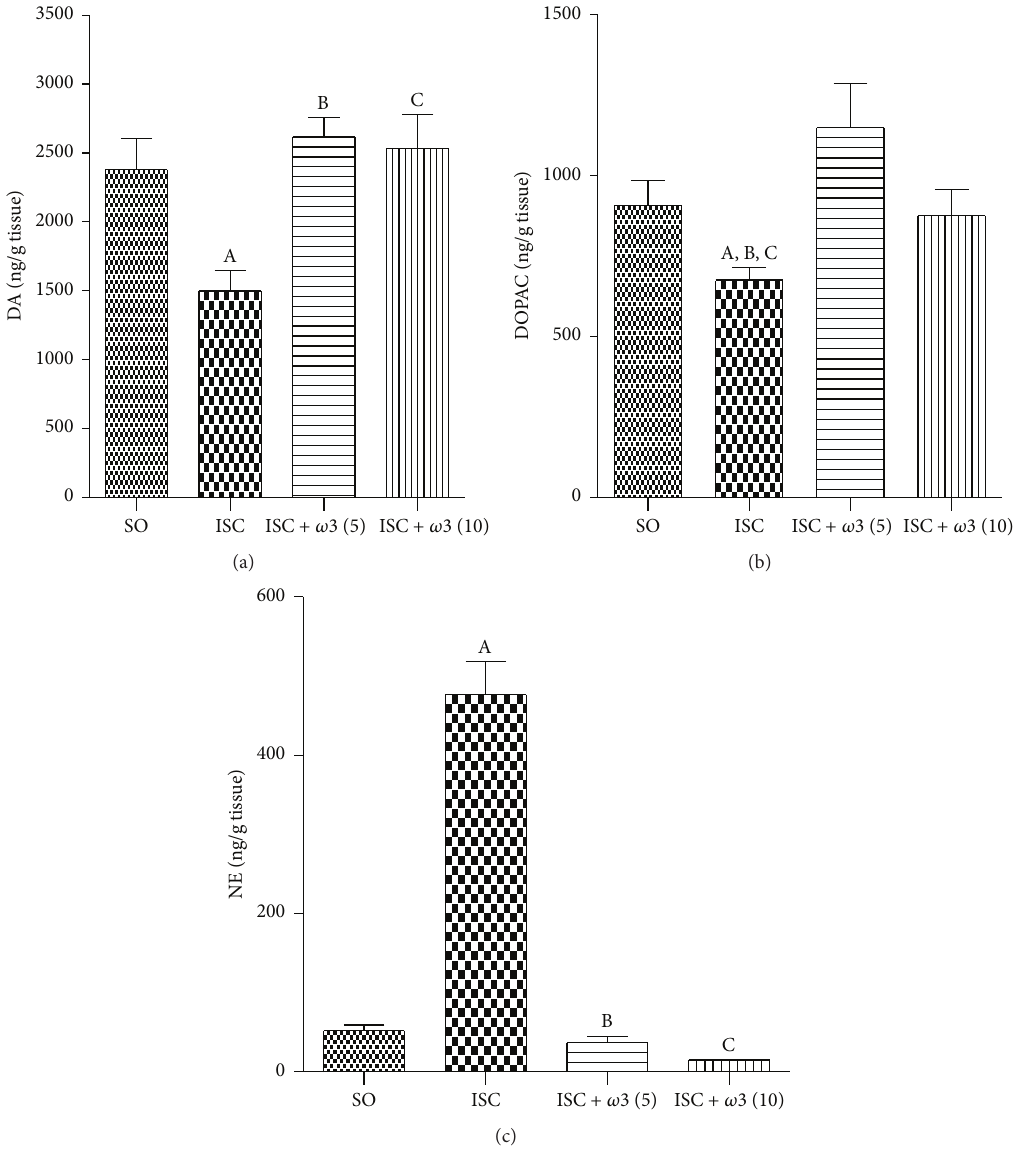
Figure 3: Evaluation of 𝜔 3 treatments at the doses of 5 and 10mg/kg on the striatal contents of DA (a), DOPAC (b), and NE (c), in rats subjected to brain ischemia and reperfusion for 7 days. The numbers of animals per group were the following: for DA, SO = 14, ISC = 9, ISC + 𝜔 3 (5) = 19, and ISC + 𝜔 3 (10) = 15; for DOPAC, SO = 14, ISC = 11, ISC + 𝜔 3 (5) = 15, and ISC + 𝜔 3 (10) = 14; for NE, SO = 8, ISC = 10, ISC + 𝜔 3 (5) = 8, and ISC + 𝜔 3 (10) = 6. The columns represent means ± SEM and the groups are sham-operated (SO); ischemic (ISC) untreated; and ischemic after 𝜔 3 treatments for 7 days. DA: (A) versus SO, q = 3.830 ∗∗ ; (B) versus 𝜔 3 (5), q = 5.145 ∗∗ ; (C) versus 𝜔 3 (10), q = 4.570 ∗∗ . DOPAC: (A) versus SO, t = 2.484, df = 23; (B) versus 𝜔 3 (5), q = 4.707 ∗∗ ; (C) versus 𝜔 3 (10), t = 2.085, df = 23. NE: (A) versus SO, q = 16.52 ∗∗∗ ; (B) versus 𝜔 3 (2.5), q = 18.79 ∗∗∗ ; (C) versus 𝜔 3 (5), q = 17.09 ∗∗∗ (one-way ANOVA and Newman-Keuls test as the post hoc